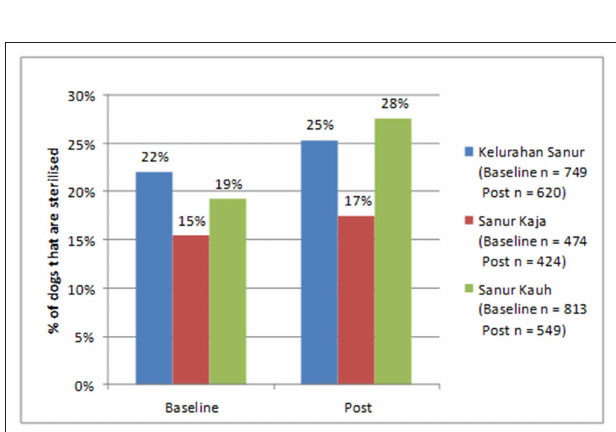
FIGURE 5 | Change in percentage of dogs that are sterilized at baseline and at their most recent visit.